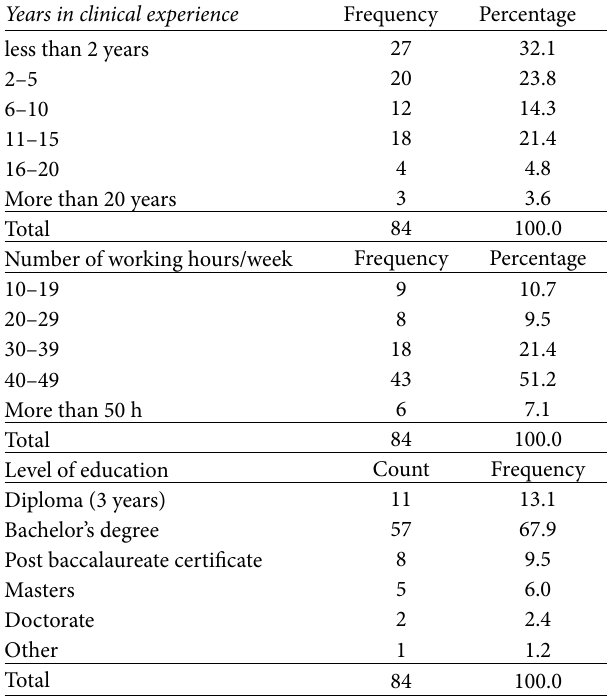
Figure 1: The distribution of physiotherapists amongst different clinical settings. Table 2: The clinical profile of